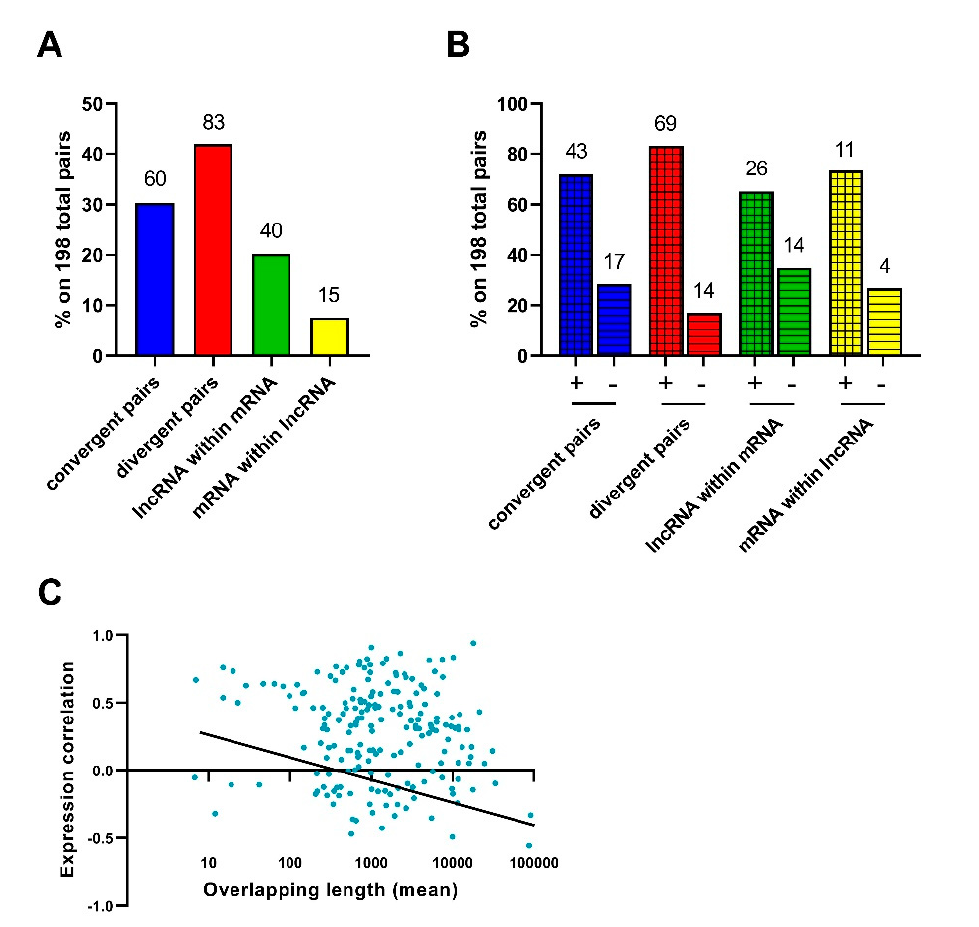
Figure 8. Sense-antisense lncRNA:mRNA overlapping pairs in UM. ( A ) Sense-antisense pairs were classified according to overlapping features in: convergent (lncRNA and mRNA overlap in their 3 (cid:48) regions), divergent (lncRNA and mRNA overlap in their 5 (cid:48) regions), lncRNA within mRNA (a shorter lncRNA totally overlapping a longer mRNA) and mRNA within lncRNA (a shorter mRNA totally overlapping a longer lncRNA). ( B ) Sense-antisense pairs divided in subgroups according to the direction of expression correlation: positive correlation is represented as a checked fill pattern of the histogram, negative correlation as a striped fill pattern. Data are shown as percentage calculated on the total number of 198 pairs; the number of pairs included in each overlapping class or subgroup is reported above each histogram. ( C ) Correlation between length of overlapping regions (mean) and expression correlation among sense and antisense